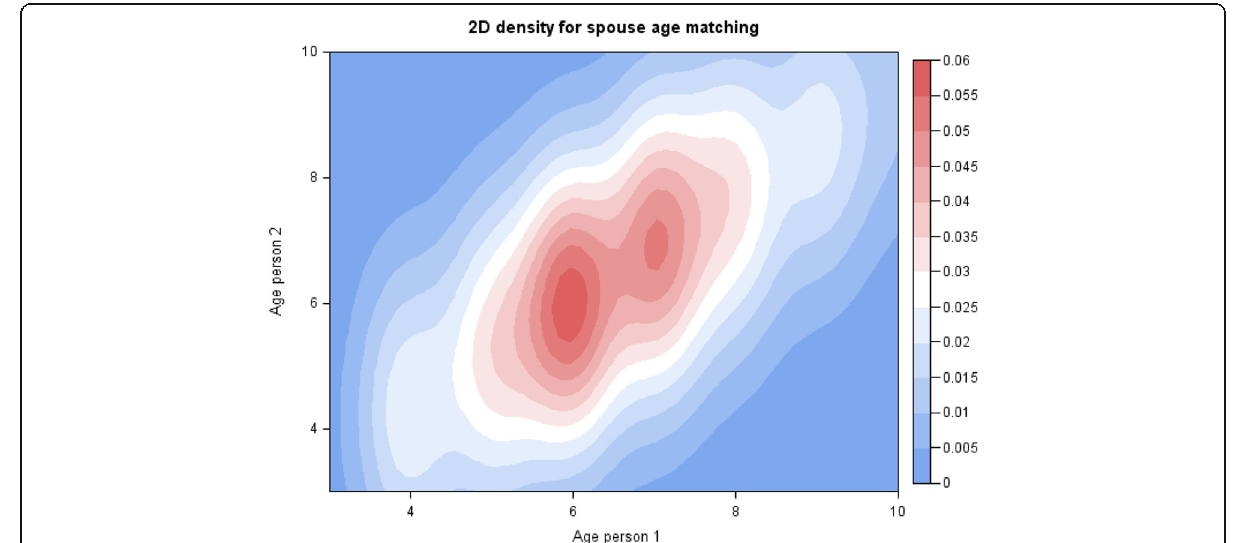
Fig. 4 Contour plot of spouse matching age